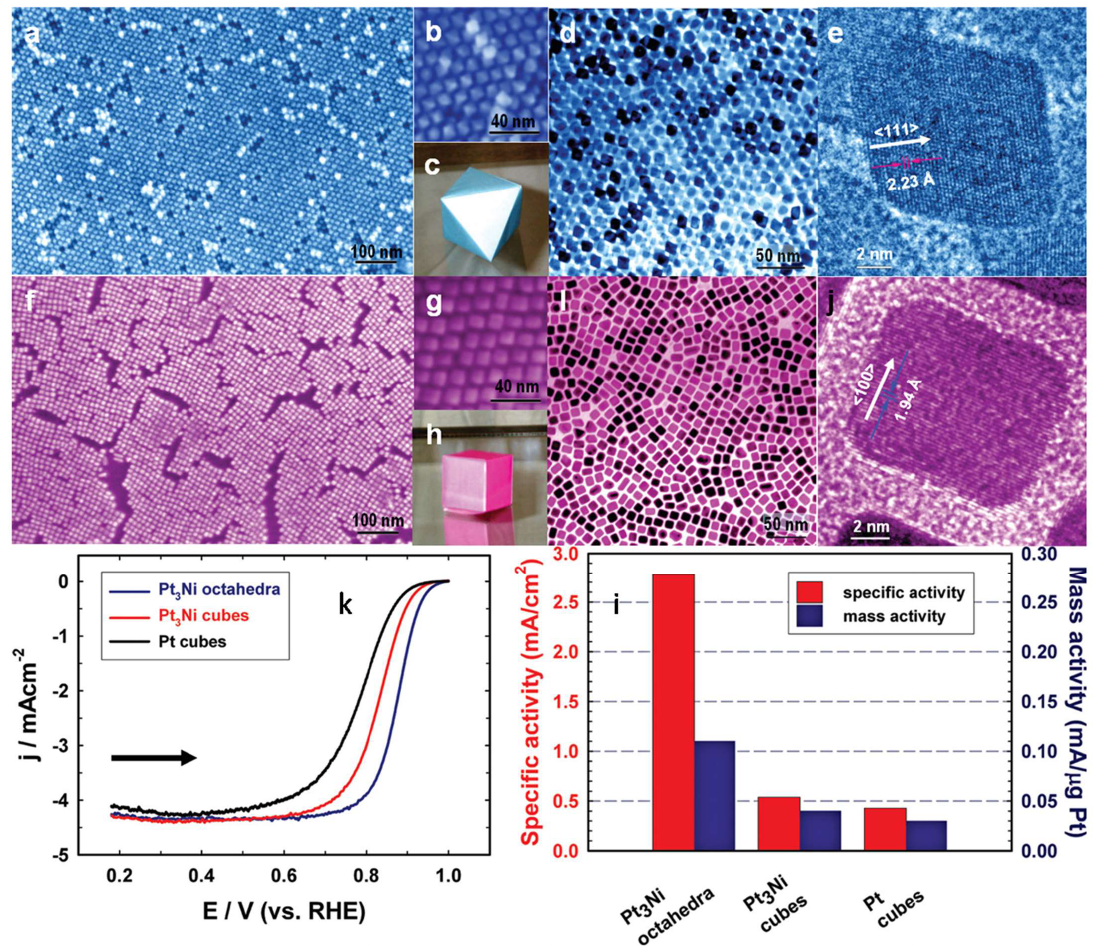
Figure 6. Images for ( a – e ) Pt 3 Ni octahedra and ( f – j ) Pt 3 Ni cubes: ( a , b , f , g ) SEM images; ( d , e , i , j ) TEM images; 3D image of ( c ) an octahedral and ( h ) a cube. ( k ) Polarization curves for ORR on Pt 3 Ni octahedra, Pt 3 Ni cubes, and Pt cubes; ( l ) Comparison of ORR activities on the above three catalysts. All measured at 0.9 V RHE at 295 K. Reproduced from ref. [100] with permission from American Chemical Society, copyright 2010.